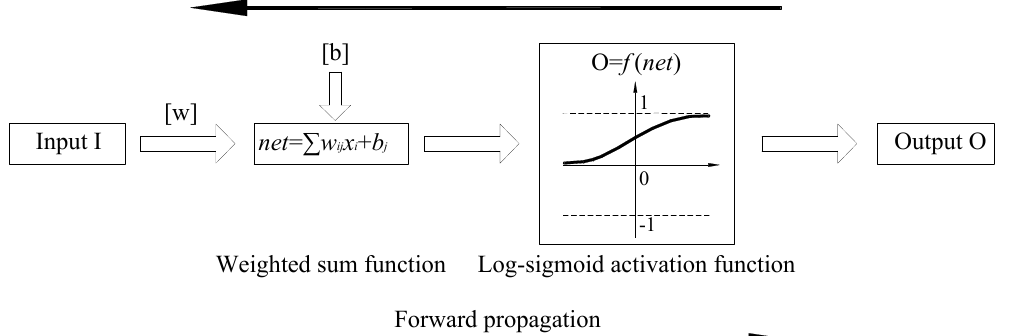
Figure 7. Architecture of the multilayer feed-forward back propagation network.